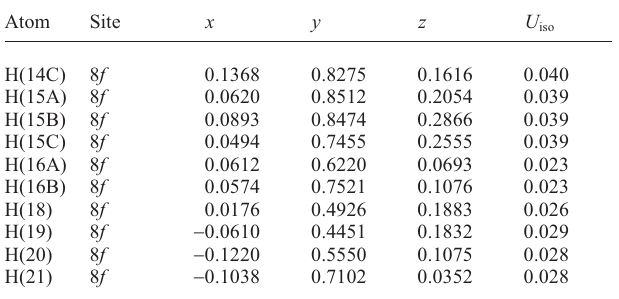
Table 3. Atomic coordinates and displacement parameters (in Å 2 )